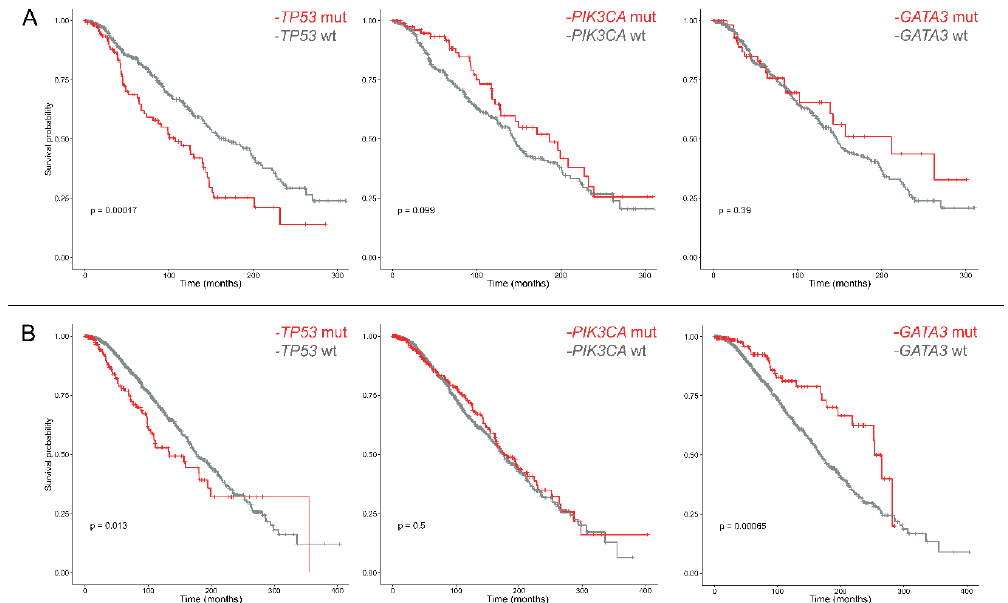
Figure 3. Overall survival of ER+/PR − ( A ) and ER+/PR+ ( B ) breast cancer patients based on TP53 , PIK3CA , and GATA3 gene alterations. For each analysis, all samples harboring mutations in one of the other two genes were excluded. Survival curves are built according to the Kaplan–Meier method.